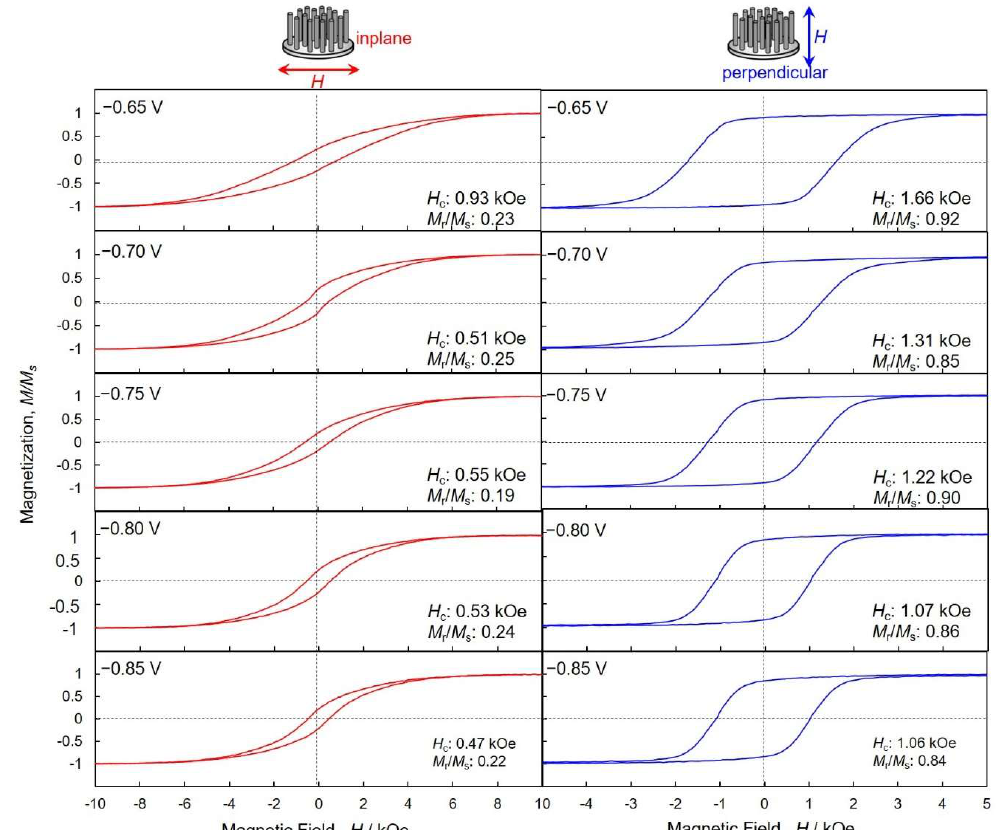
Figure 9. Magnetic hysteresis loops of Co nanocrystal arrays that were electrodeposited at each cathode potential ranging from − 0.85 V to − 0.65 V in AAO nanochannel films. Magnetic field was applied to inplane (red lines) and perpendicular (blue lines) direction to the films.